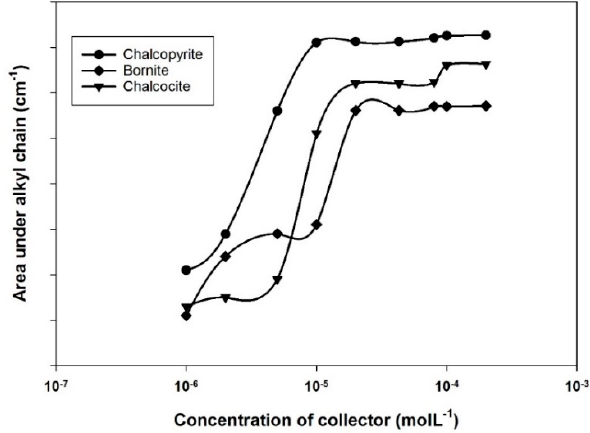
Figure 15. The area under the alkyl chain bands for chalcopyrite, chalcocite and bornite in the presence of SIBX and DBD blend (1:1).